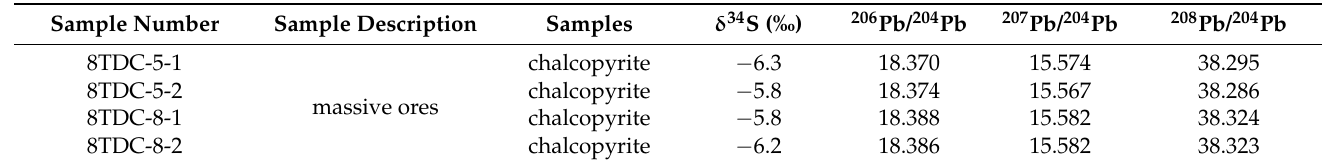
Table 3. The S and Pb isotope compositions of sulfides from the Toudaochuan deposit.